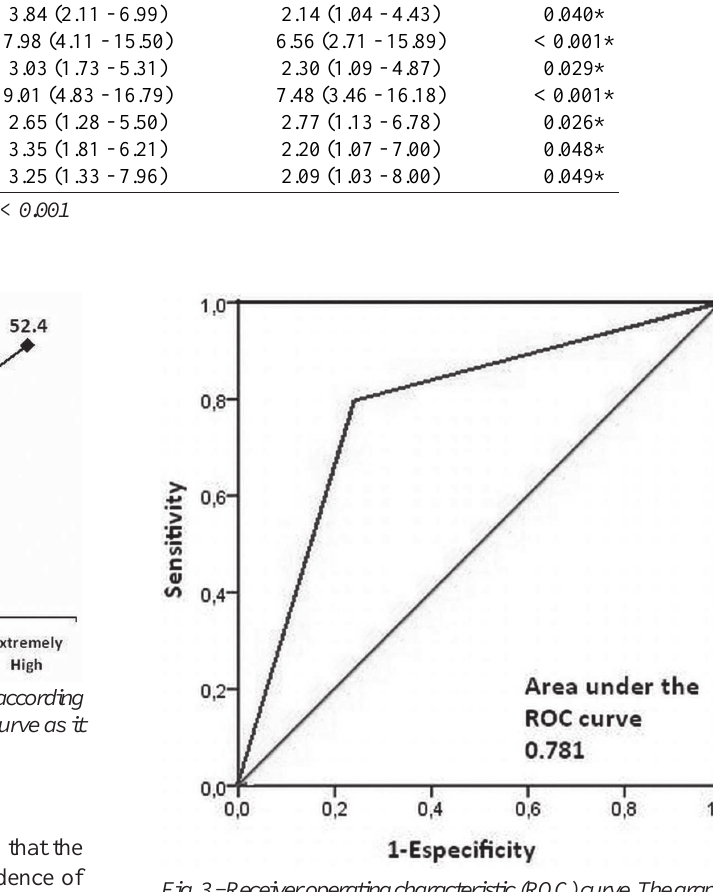
Fig. 3 - Receiver operating characteristic (ROC) curve. The graphic shows the good accuracy of the